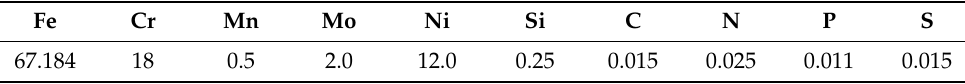
Table 2. Chemical composition of